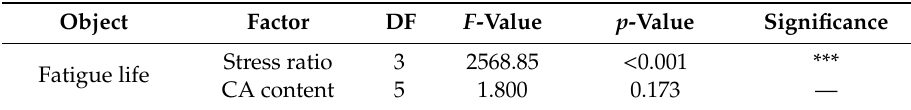
Table 8. Two-way ANOVA results for fatigue test.